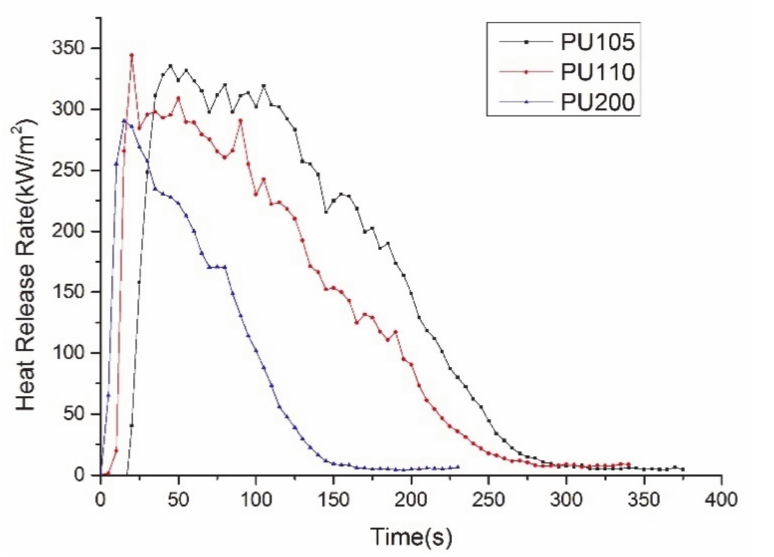
Figure 4. Heat release rate of PU 105, PU110, and PU200.